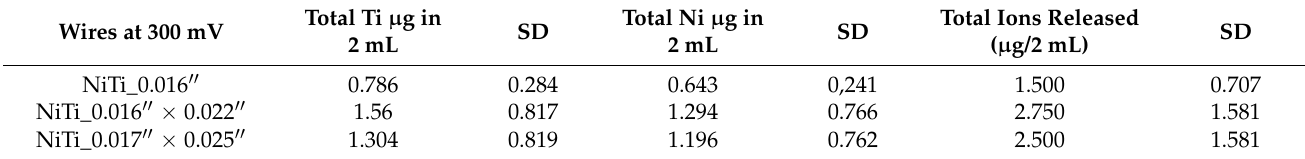
Table 7. The average expected ion release from the NiTi wires at 300 mV.